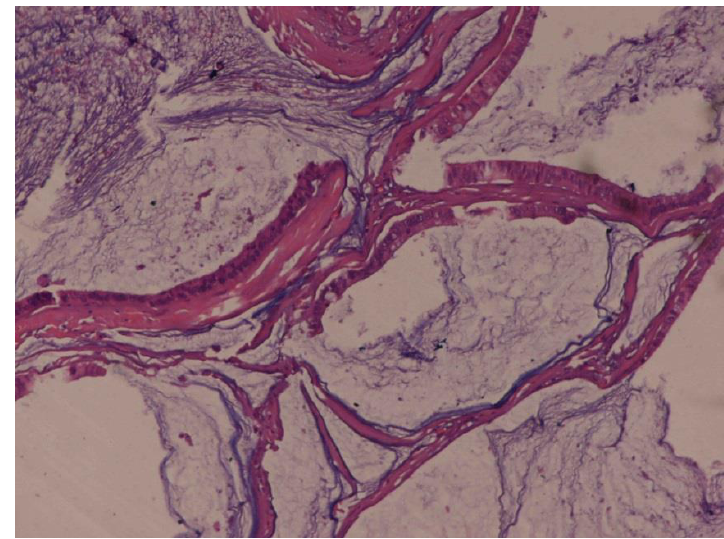
Figure 1. Microscopically, the tumour consisted of elongated, anastomosing tubules separated by lakes of mucin from a prominent spindle cell area. The tubules were composed of low cuboidal cells with an amphophilic to eosinophilic cytoplasm with low-grade nuclei. Foci of sarcomatoid differentiation were seen with pleomorphic high-grade nuclei without any evidence of vascular invasion. Haematoxylin and eosin, 10×.